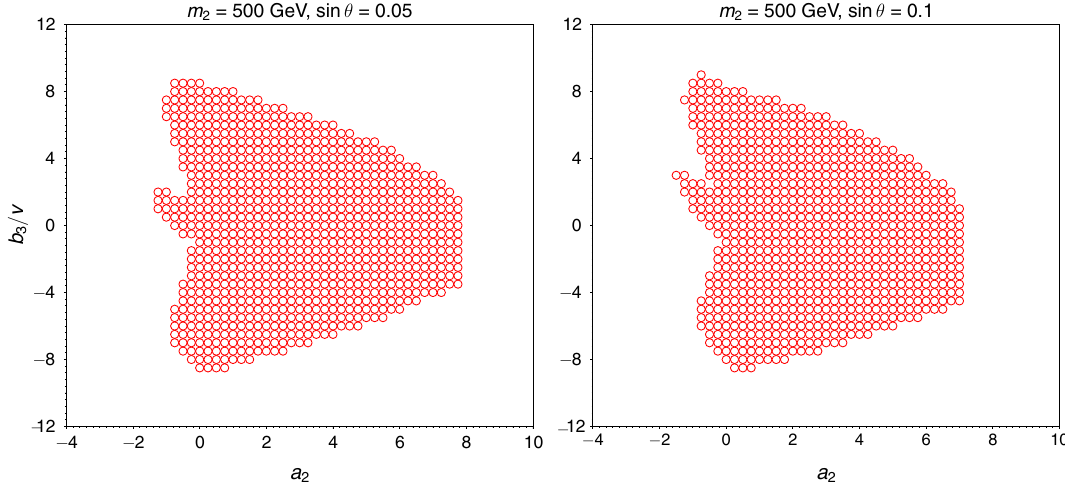
Fig. 10 Region of parameter space in ( a 2 , b 3 /v ) and fixed m 2 = 300 GeV and sin θ = 0 . 05 (left), sin θ = 0 . 1 (right), compatible with the requirements of unitary, perturbativity and absolute stability of the EW vacuum. The parameter b 4 has been scanned over (see text for details)